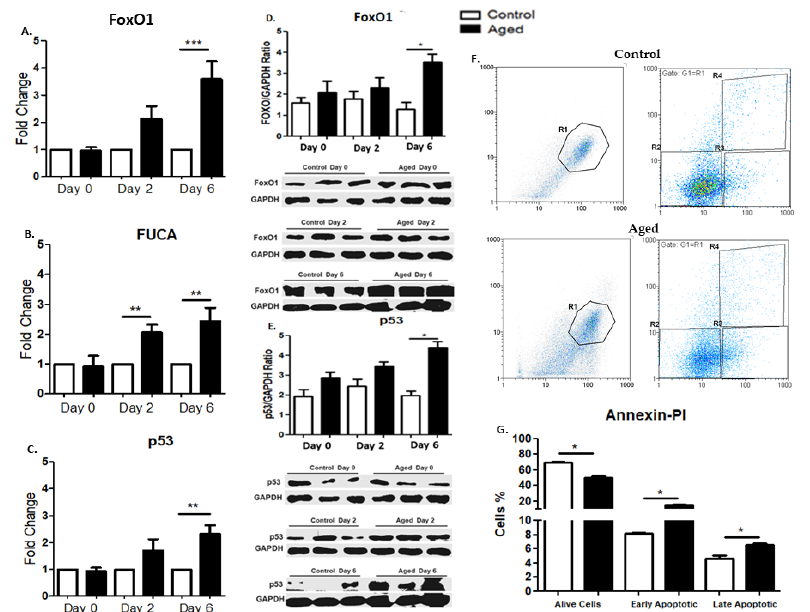
Figure 4. ( A – C ) Effects of myoblast aging on the expression of pro-apoptotic genes during myogenic differentiation. Quantitative analysis of FoxO1 ( A ), FUCA ( B ), and p53 ( C ) mRNA expression in aged myoblasts compared to controls during their differentiation. The mRNA expression values of pro-apoptotic factors in the aged myoblasts have been normalized to the corresponding GAPDH mRNA and are expressed as fold changes compared to control myoblasts. ( D , E ) Effects of myoblast aging on the expression of pro-apoptotic proteins FoxO1 and p53.Representative Western blots and immunoblotting quantification of FoxO1 ( D ) and p53 ( E ) in aged myoblasts compared to control cells during their myogenic differentiation. The values of the apoptotic proteins were normalized to each corresponding GAPDH on the same immunoblot. ( F , G ) Effects of myoblast aging on cell death (Annexin-PI). ( F ) Histograms from a representative experiment show the apoptotic effect of senescence on myoblasts. The percentages of necrotic, live, early apoptotic, and late apoptotic cells are displayed in R1, R2, R3 and R4, respectively. ( G ) Bar graphs show that senescence induced the apoptosis of (aged) myoblasts. Quantitative results (R2–R4) are displayed aspercentagechanges compared to the control. (Mean ± SE of 3 independent experiments performed in triplicate; * p < 0.05, ** p < 0.01, *** p < 0.001).